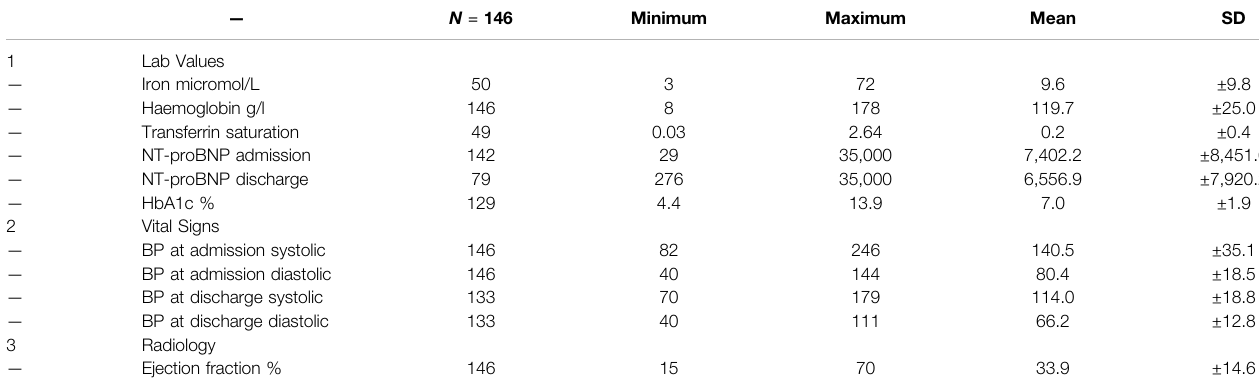
TABLE 4 | Lab values, radiology and vital signs distribution pattern.